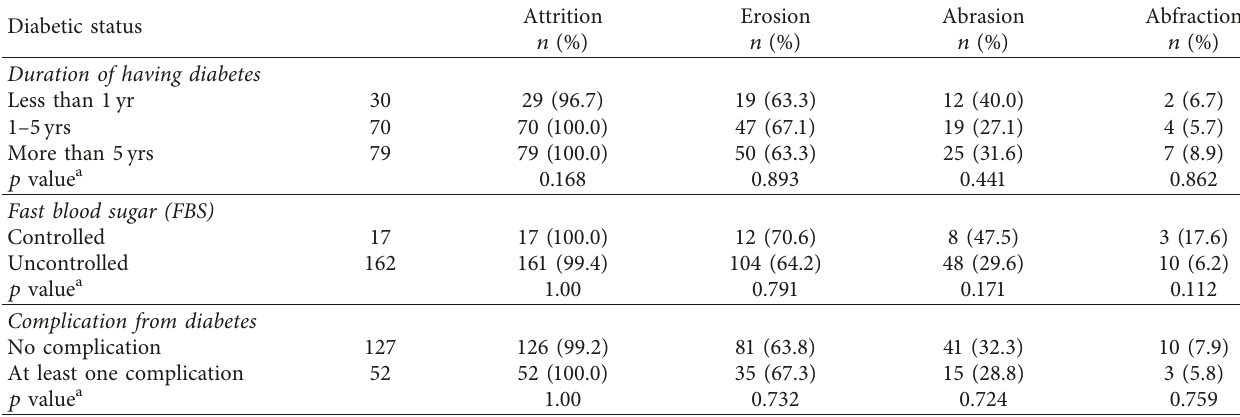
Table 4: Tooth wear and diabetic